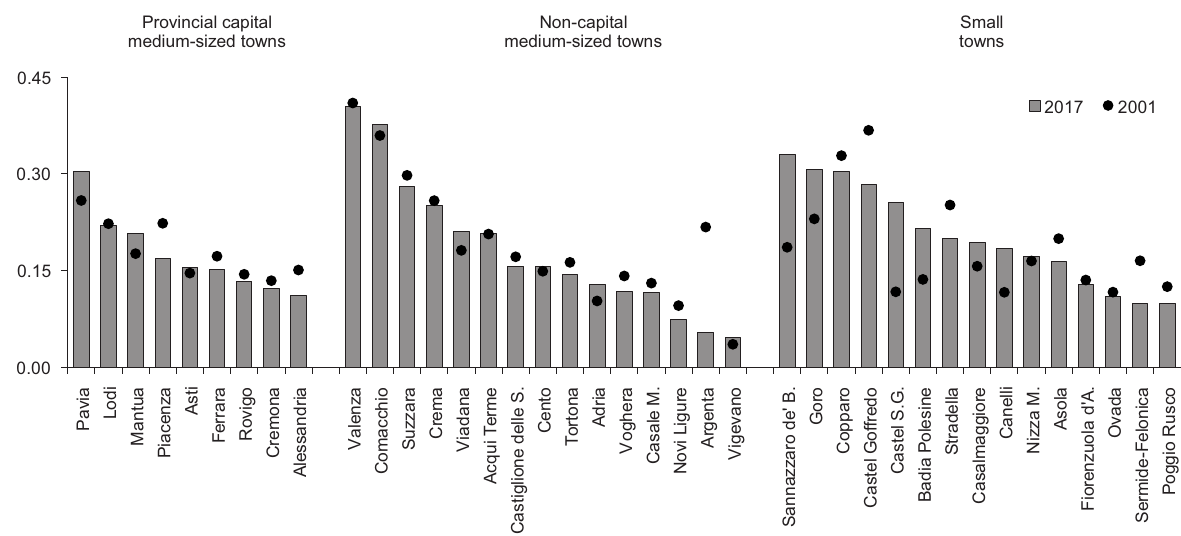
Fig. 5. Specialisation index in the 39 towns analysed (2001, 2017), in descending order in 2017 by type of town.